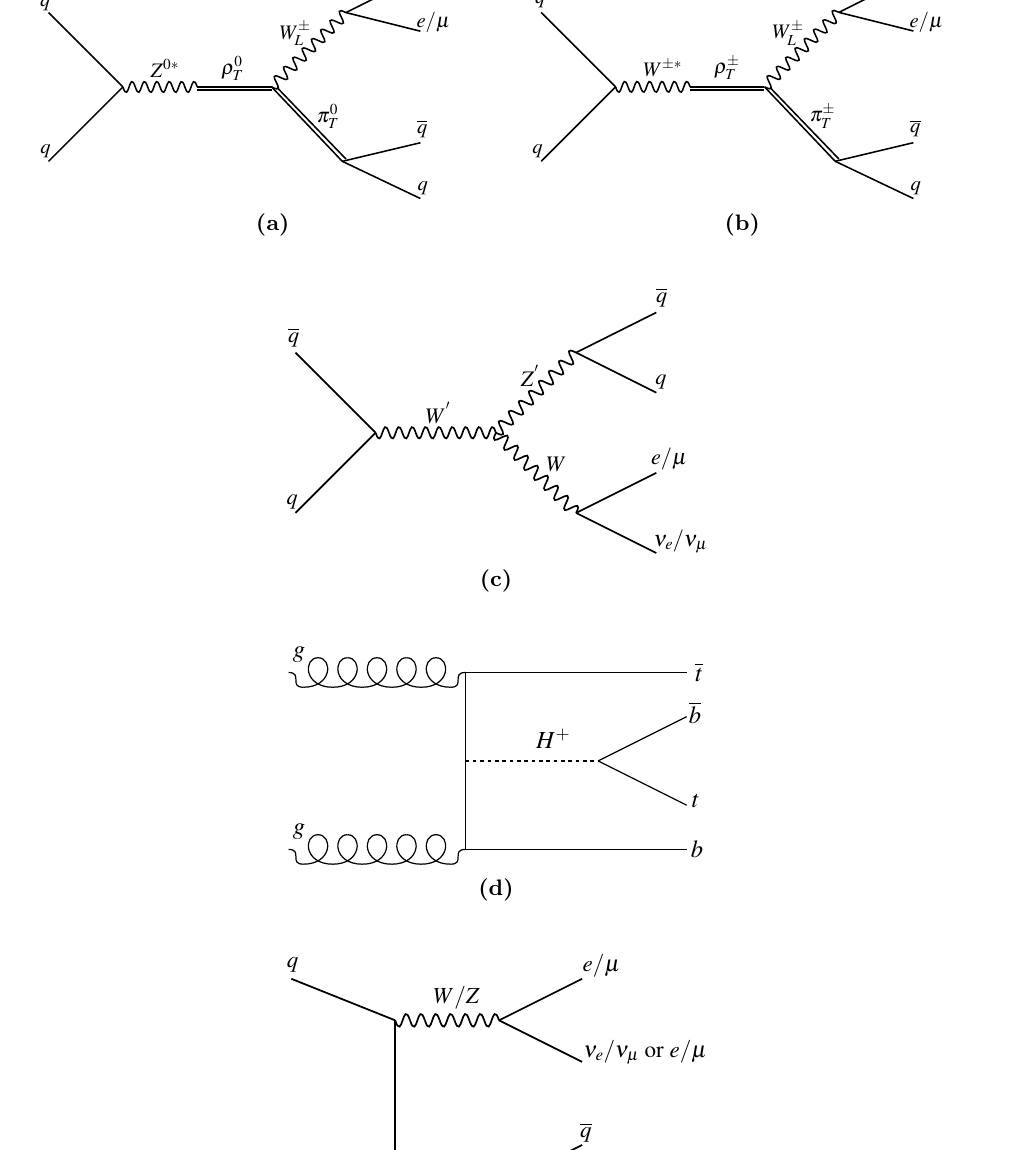
Z 0 W (cid:6) production in !